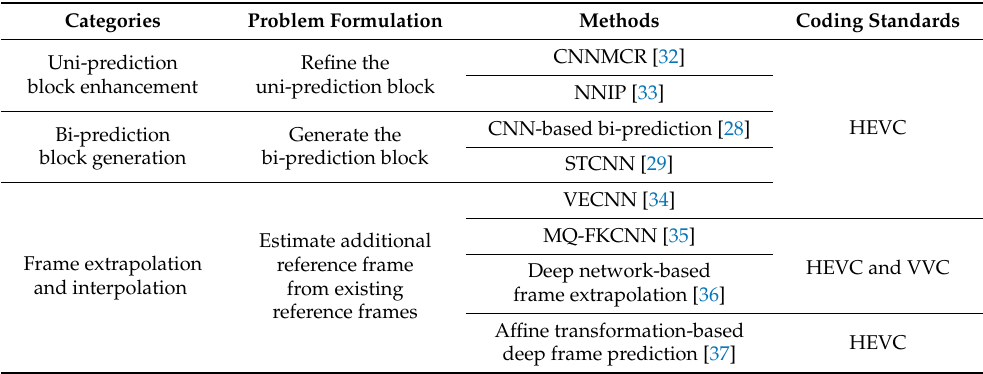
Table 1. Problem formulation and related methods for deep learning-based inter prediction in video